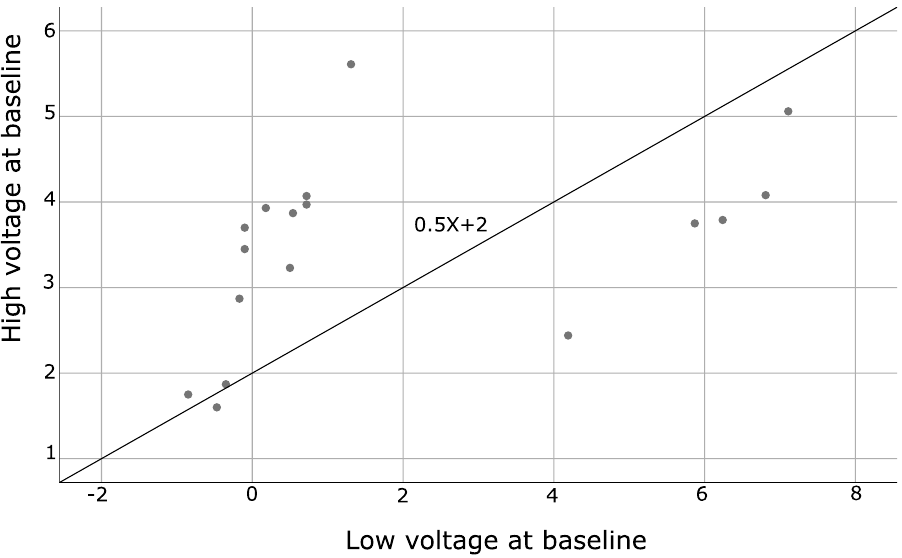
Figure 7. Illustrates the correlation between low and high voltage values measured at baseline of SA patients.